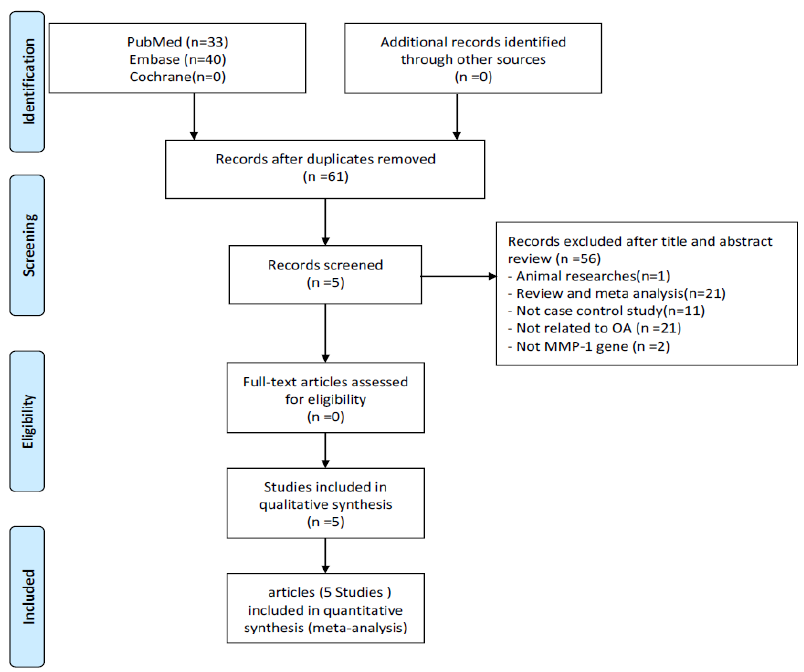
Figure 1. Flow diagram of the identification process for eligible studies.